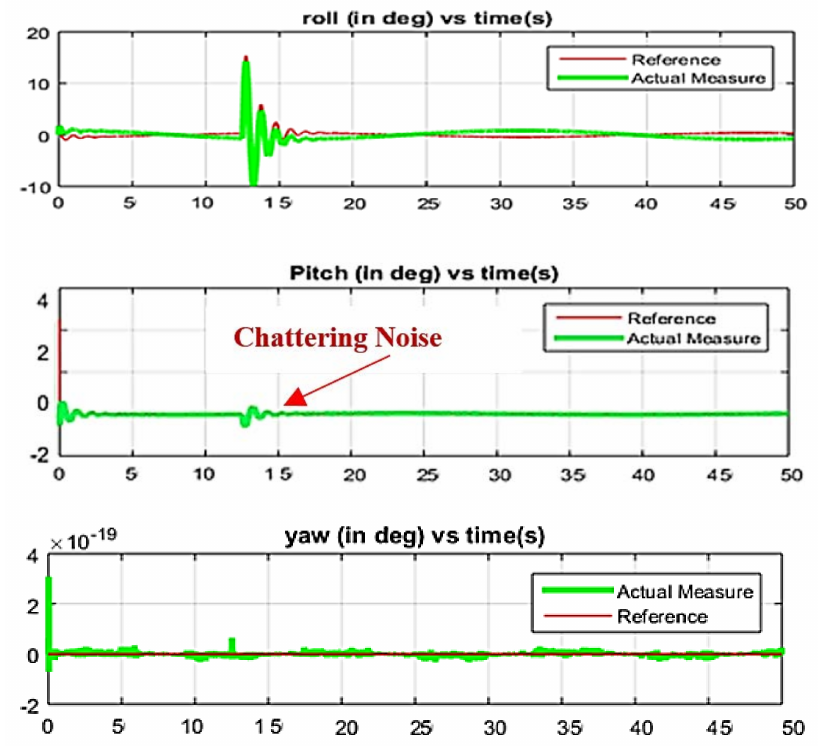
Figure 6. Roll, pitch, and Yaw Responses by Backstepping Control under no disturbances. When the unmodelled dynamic factor in the form of sine function is added into the system. The positional and angular velocities, that is, roll, pitch and yaw are no longer same. Moreover, the trajectory tracking is also having some deviation. These changes can be experienced in Figures